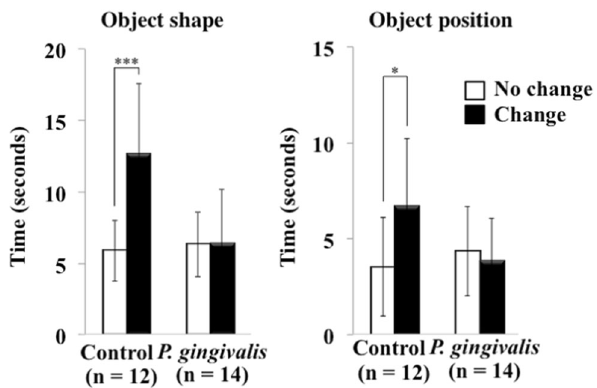
Fig. 2 Evaluation of cognitive function in P. gingivalis -infected APP- Tg mice. Results are expressed as means ± S.D., * p < 0.05, *** p <